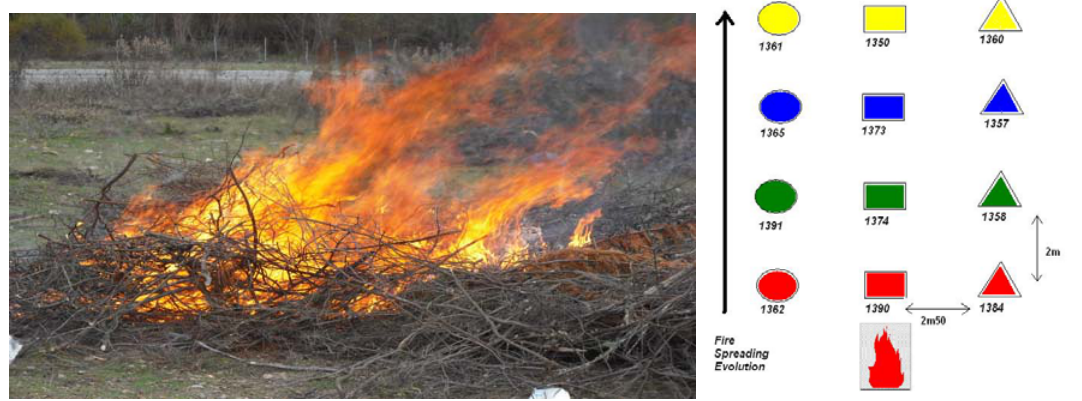
Figure 4. MICA 3 rd GEN Experimental Area with 12 sensors on a square with 2 m 50 in width and 2 m distance between the nodes.